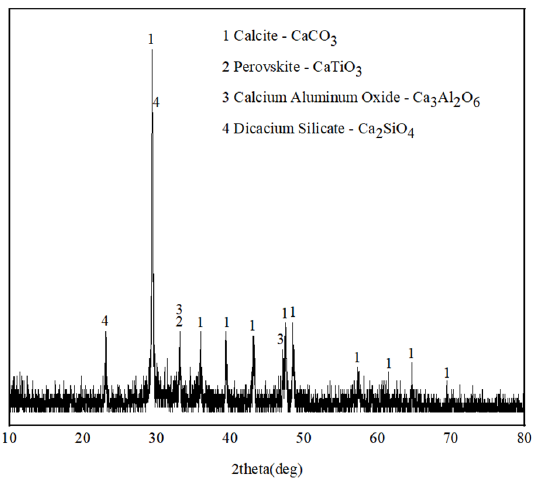
Figure 1. The XRD patterns of red mud from the sintering process. Table 1. Chemical composition of raw materials (wt.%).